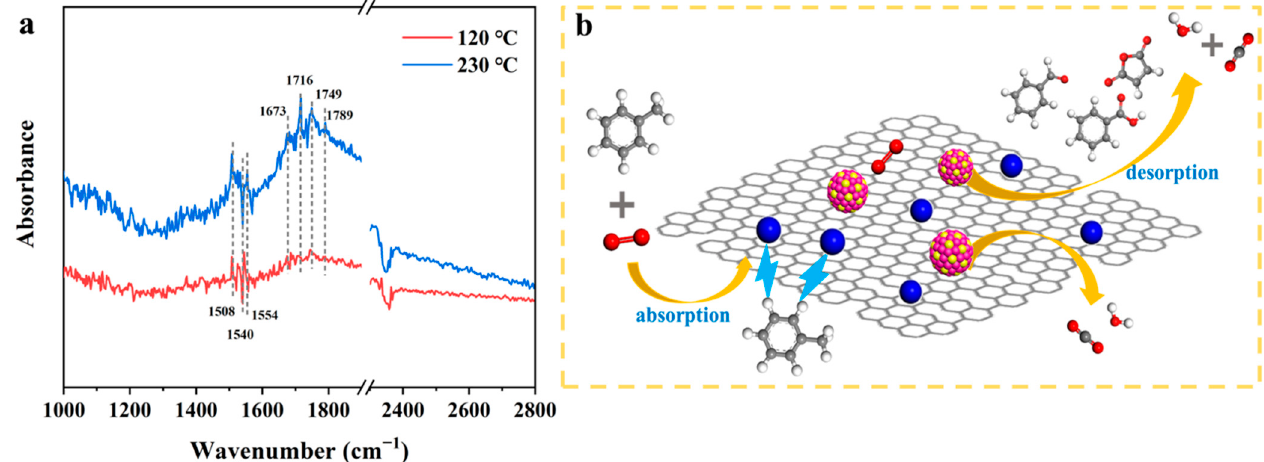
Figure 11. In situ DRIFTS spectrum of PtCo 3 -su ( a ) and probable toluene oxidation mechanism on PtCo 3 -su catalyst ( b ).